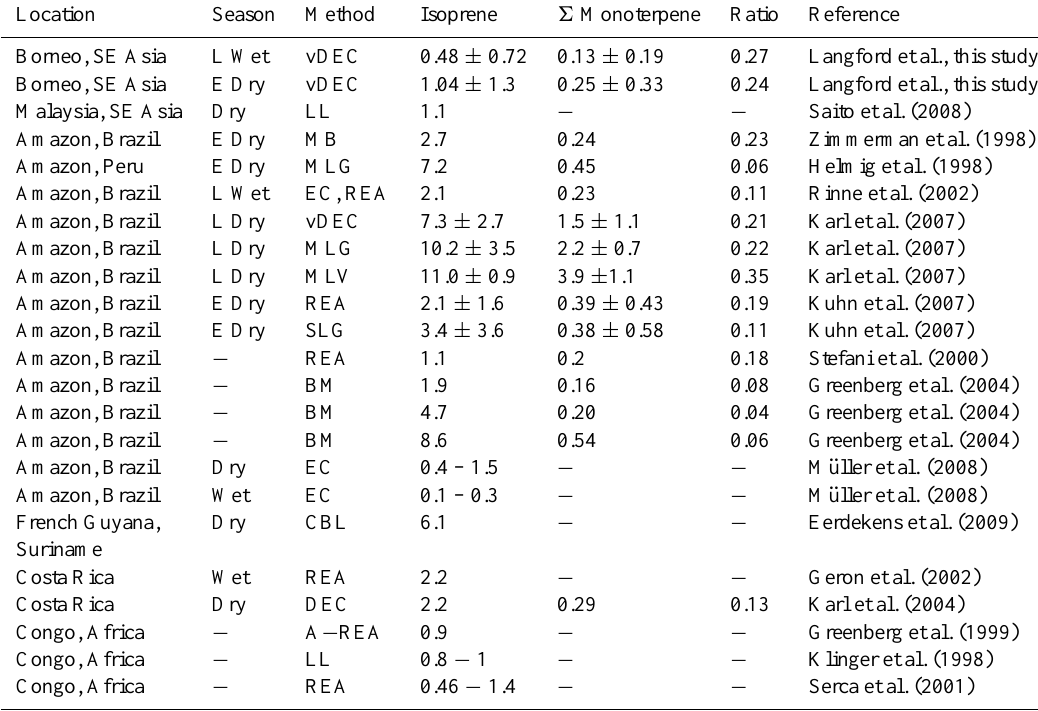
Table 3. Isoprene and monoterpene flux measurements from the world’s tropical forests and their typical ratios (monoterpene/isoprene). All values are in units of mg C m − 2 h − 1 . Where available, errors show ± 1 standard